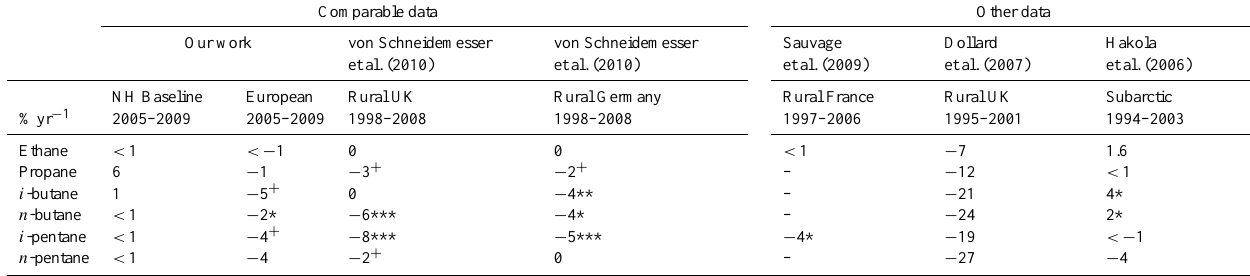
Table 2. Trends of hydrocarbons (%yr − 1 ) measured at Mace Head in baseline and European air masses from 2005–2009 calculated using the Mann-Kendall test.